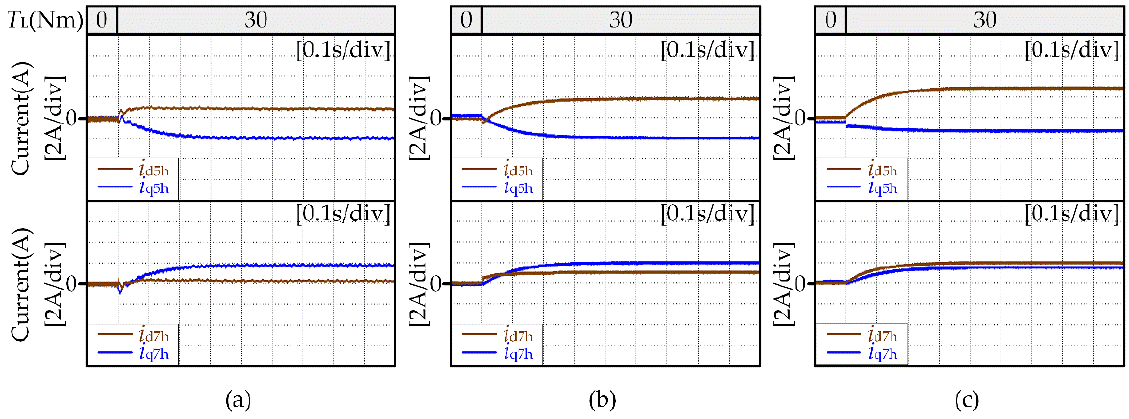
Figure 13. The 5th and 7th current harmonic components extracted by the proposed method when the load torque is 30 Nm. ( a ) 100 rpm; ( b ) 1000 rpm; and ( c ) 2500 rpm.